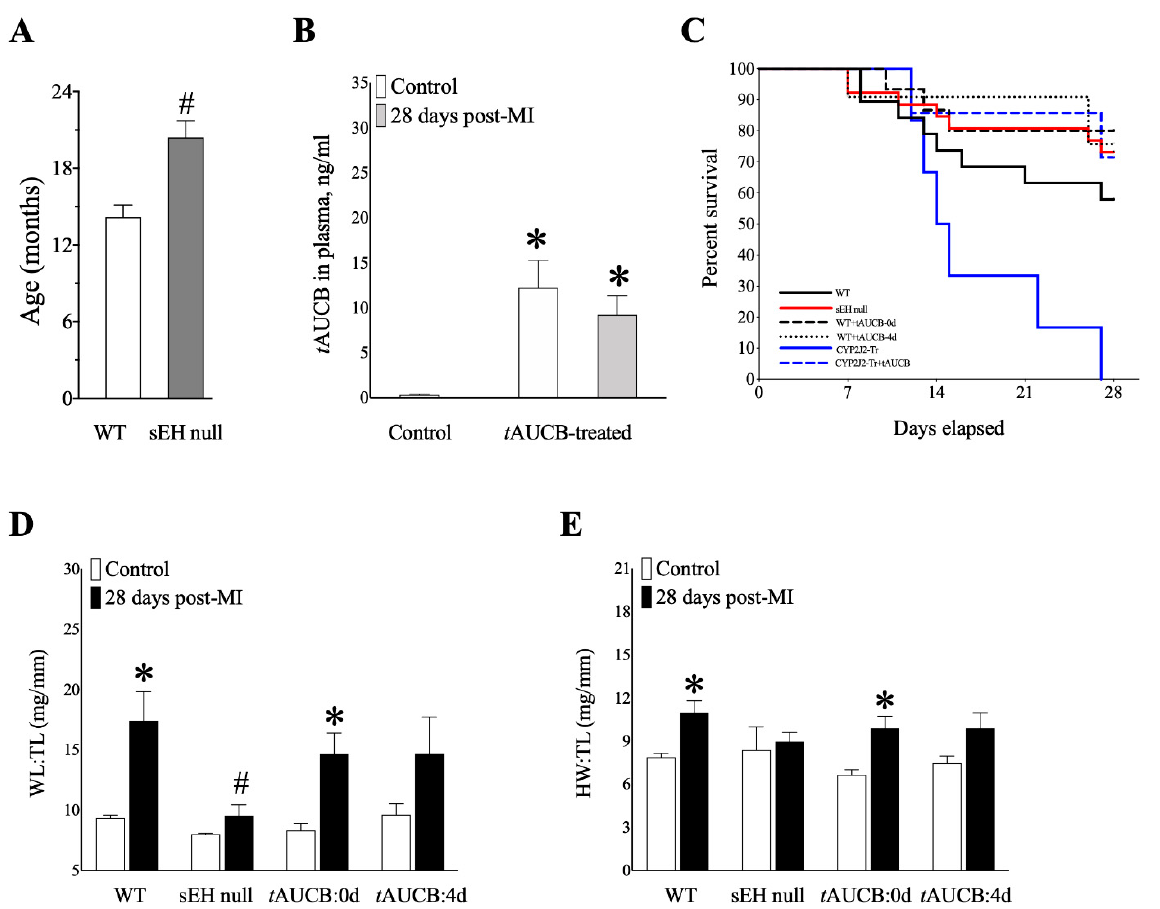
Figure 2. Physiological parameters and survival for female mice at baseline and 28 days post-MI. ( A ) Lifespan (months) for WT and sEH null female mice determined over natural aging. n = 40–46. ( B ) t AUCB levels (ng/mL) in plasma for WT vehicle-treated sham control mice and t AUCB-treated sham and 28 days post-MI females. ( C ) Percentage survival of female mice over 28 days of LAD ligation for WT (11/17, 58%) sEH null (19/26, 73%), WT+ t AUCB:0d (12/15, 80%), WT+ t AUCB:4d (5/6, 83%), CYP2J2-Tr (0/6, 0%), CYP2J2-Tr+tAUCB:0d (5/7, 71%). ( D ) Wet lung (WL) to tibia length (TL) (mg/mm) and ( E ) heart weight (HW) to TL (mg/mm) of WT, sEH null, tAUCB:0d- and tAUCB:4d-treated mice for control and at 28-days post-MI. Data are means ± SEM, n = 3–10. p ≤ 0.05; * vs. Control; # vs. WT group;